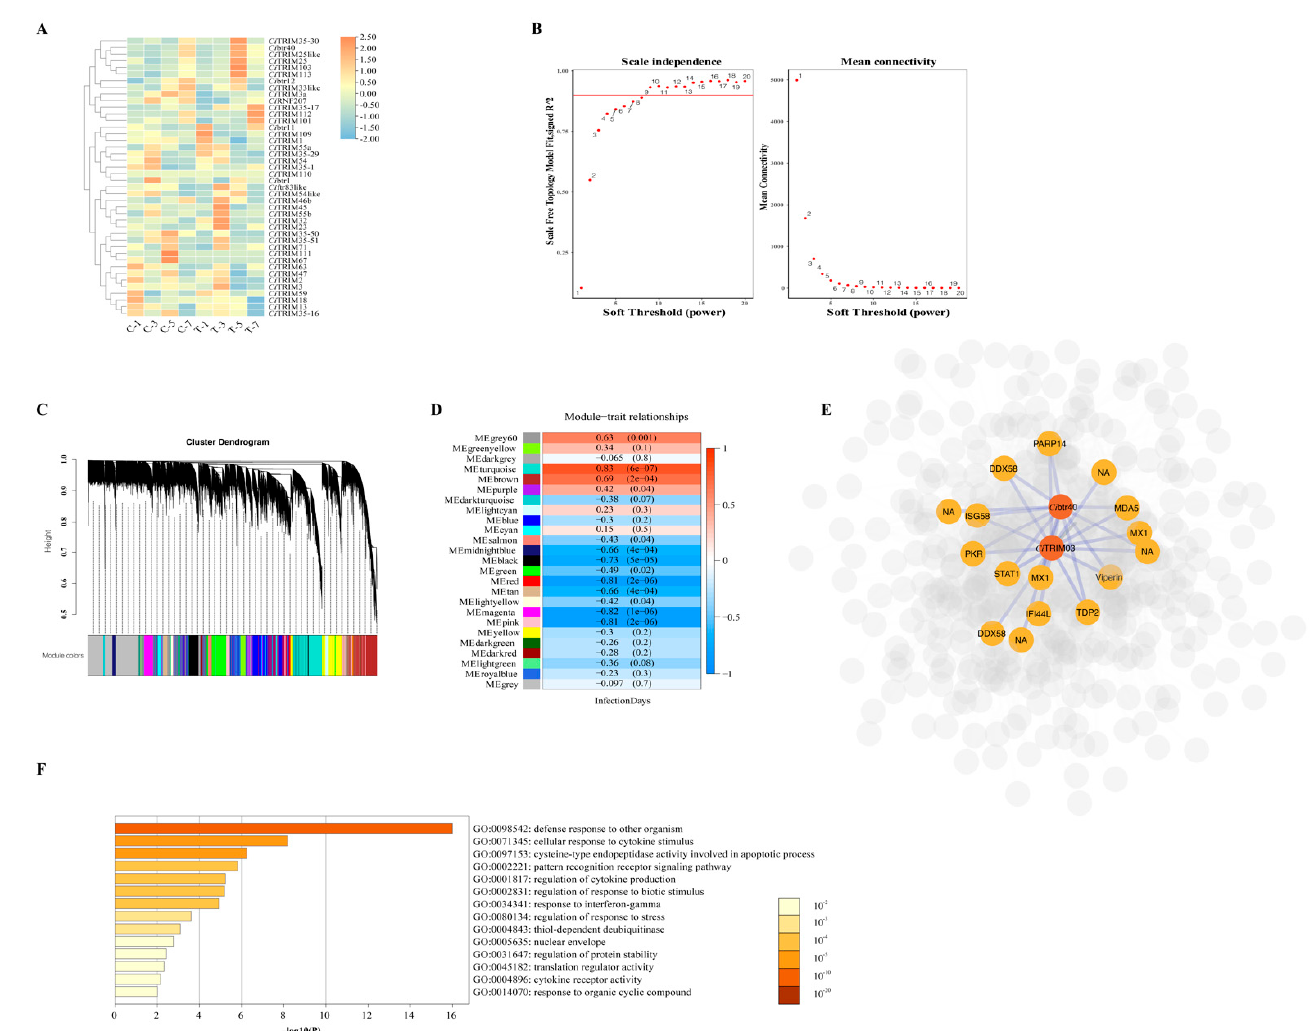
Figure 5. Transcriptome analyses of the spleens from grass carp infected with GCRV within 7 days. ( A ) Heatmap of 42 Ci TRIMs’ expression changes in spleen after GCRV infection on days 1, 3, 5 and 7. C-1: control group, day 1; C-3: control group, day 3; C-5: control group, day 5; C-7:control group, day 7; T-1: treatment group, day 1; T-3: treatment group, day 3; T-5: treatment group, day 5; T-7: treatment group, day 7. ( B ) Analysis of network topology for various soft-thresholding powers. The left panel shows the scale-free fit index (y-axis) as a function of the soft-thresholding power (x-axis). The right panel displays the mean connectivity (degree, y-axis) as a function of the soft-thresholding power (x-axis). ( C ) Clustering dendrogram of genes, with dissimilarity based on topological overlap, together with assigned module colors, that contain a cluster of genes with similar biological functions. ( D ) Pearson correlation analysis of module and trait (infection time points). Each cell contains the Pearson correlation coefficient and Student asymptotic p -value. The correlation intensity color is illustrated by the legend on the right. ( E ) Gene co-expression network in brown module. Ci btr40, Ci TRIM103 and 12 genes, including DDX58 (RIG-I-like receptor), PKR, Viperin, MDA5, STAT1, MX1 and ISG58, with the highest node degree distribution value were highlighted in the network. ( F ) GO enrichment analysis of genes in the brown module using Metascape. Only top 14 enriched GO terms are shown. The color shade reflects the significance ( p -value) of the GO enrichment analysis, which is represented as –log10(P) on the bottom coordinate ruler